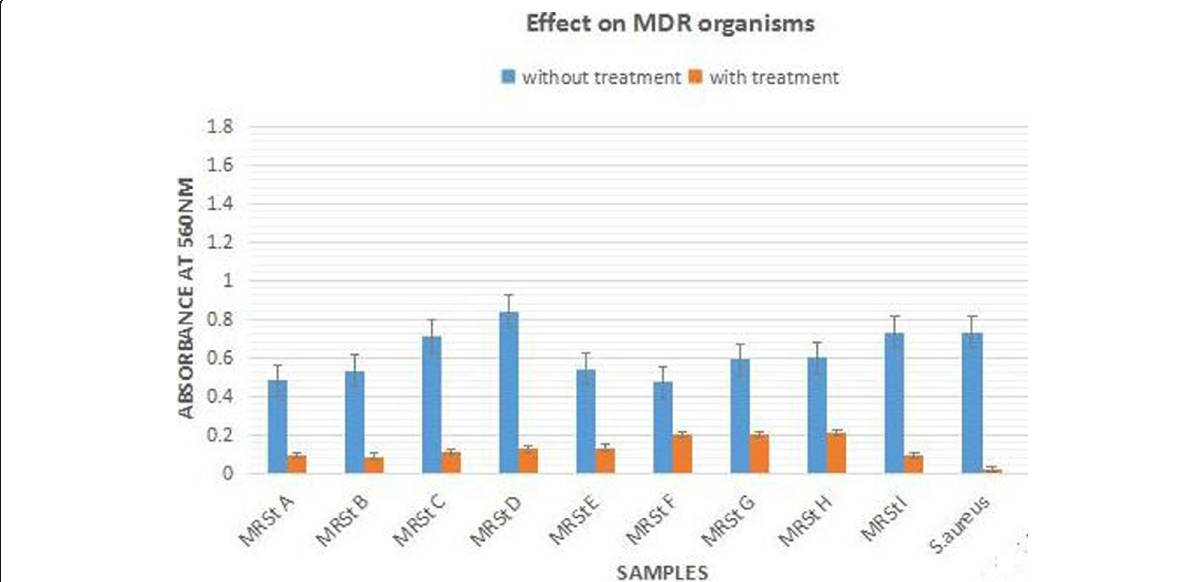
Fig. 1 Growth of organisms measured in terms of absorbance at 560 nm when treated with cell lysate of selected LAB consortium. Error bars indicate standard deviation. * S.aureus NCIM 2127